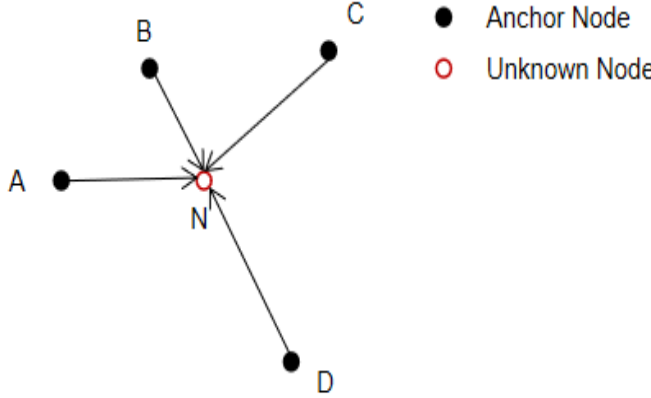
Figure 1. Maximum likelihood estimation localization